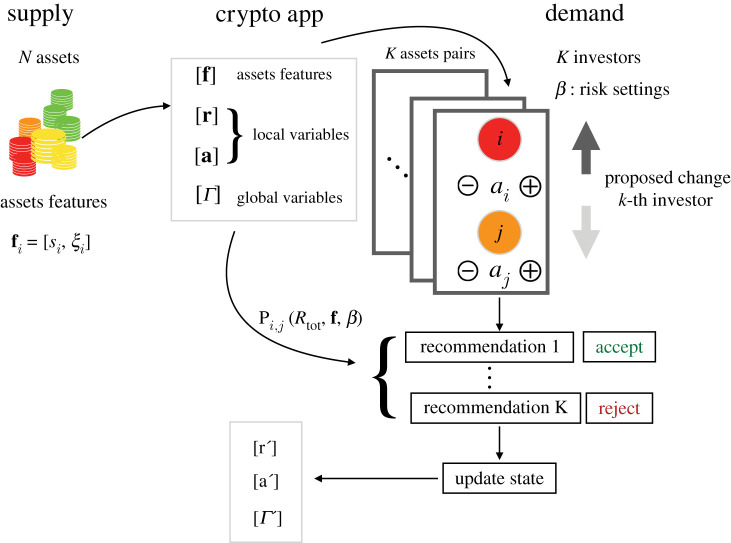
Scheme of the main components of the optimal selection model. Supply: the crypto assets landscape is composed of N assets with security (s)–stability (ξ) features contained in the vector fi,∀i=1,…,N. Crypto app: this digital platform (i) aggregates information [Γ] about the supply [f], expected returns [r] and investors’ adoption preferences [a] at previous times. (ii) It stores information about adoption and (iii) provides recommendations on adoption choices. Demand: K investors sequentially update and provide information on their adoption preferences by comparing via the app pairs of crypto assets. The β parameters tune the investors’ attitudes towards assets’ features.